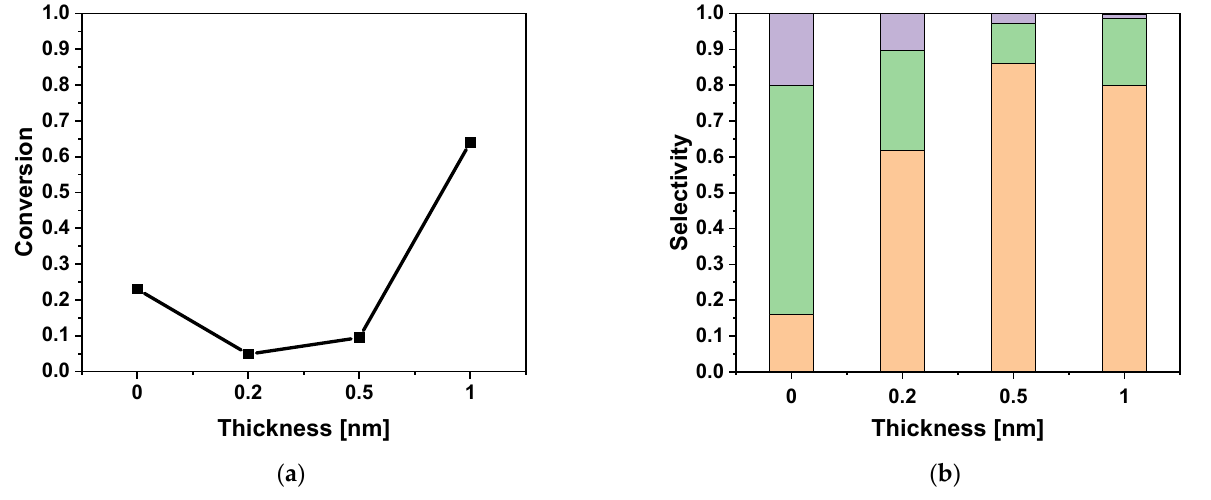
Figure 8. ( a ) THF conversion at 673 K on MAO and on 0.2 nm, 0.5 nm, and 1 nm ZrO 2 films on MAO (WHSV = 1.86 g THF/g cat/h). ( b ) The corresponding product selectivities: orange (bottom)-butadiene; green (middle)-propene; purple-butene (top).